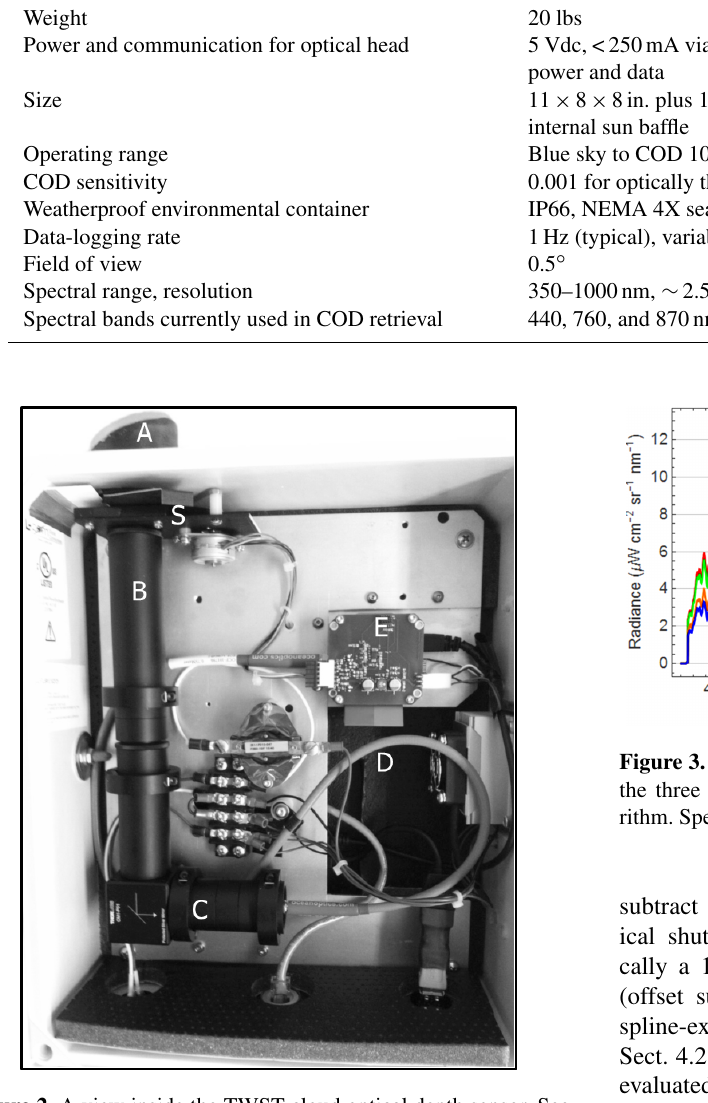
Figure 2. A view inside the TWST cloud optical depth sensor. See text for labeled component descriptions.